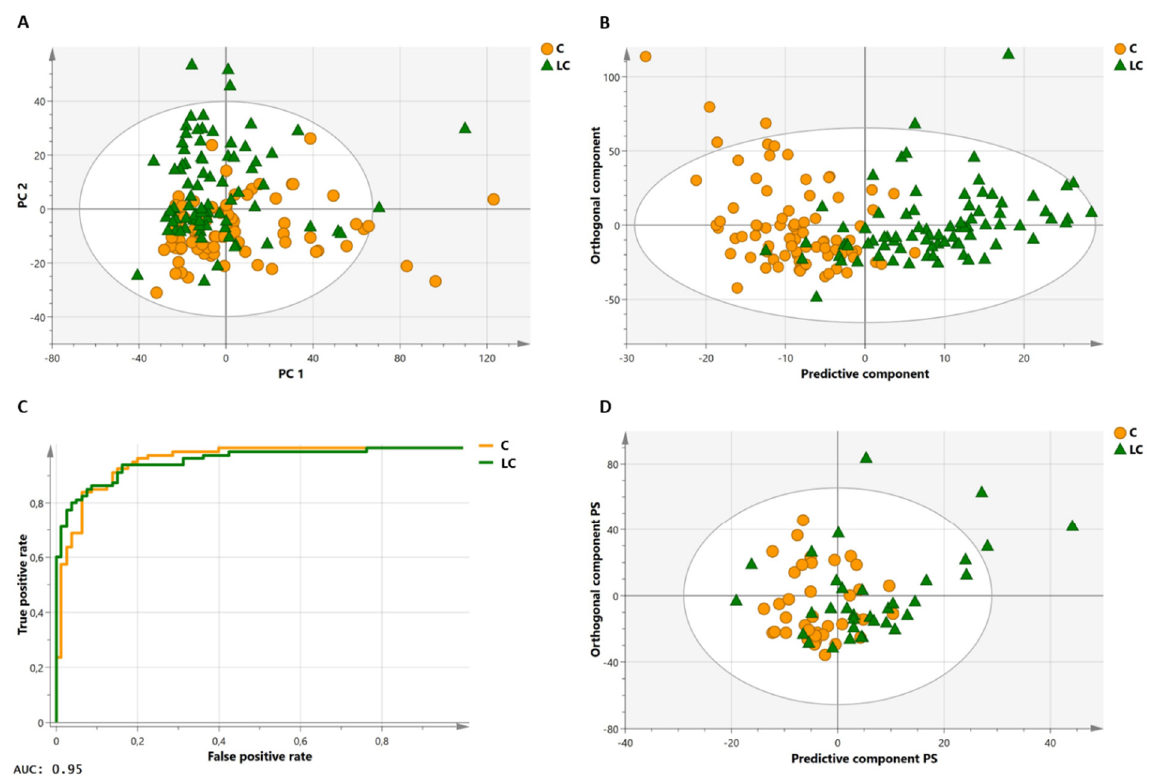
Figure 4. Multivariate statistical analyses on a large lung cancer cohort to validate the proposed methodology. ( A ) Principal component analysis (PCA) of the training cohort showing clustering of the two groups. Using only the first two principal components, the PCA model shows an R 2 value of 0.775 and a Q 2 value of 0.746. ( B ) Orthogonal partial least squares discriminant analysis (OPLS-DA) classifier of the training cohort consisting of 80 controls and 80 lung cancer patients. The training model discriminates between the two groups with 93% specificity and 85% sensitivity. ( C ) The receiver operating characteristic (ROC) curve of the trained classifier shows high predictive accuracy with an AUC of 0.95. ( D ) Validation of the OPLS-DA classifier on an independent validation cohort consisting of 38 controls and 34 lung cancer patients. The validation cohort discriminates between the two groups with a specificity and sensitivity of 74%. AUC: area under the curve; C: controls; LC: lung cancer patients; PC: principal component; PS: predicted scores.